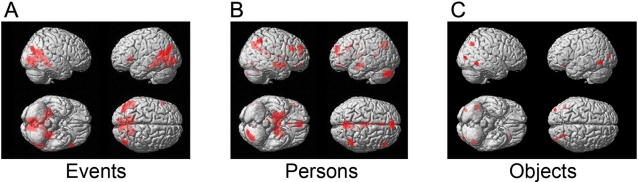
Statistical parametric maps rendered onto a template structural brain, showing category-specific activity as assessed by conjunction analysis, in the comparisons of (A) events > non-events, (B) persons > non-persons, and (C) objects > non-objects.